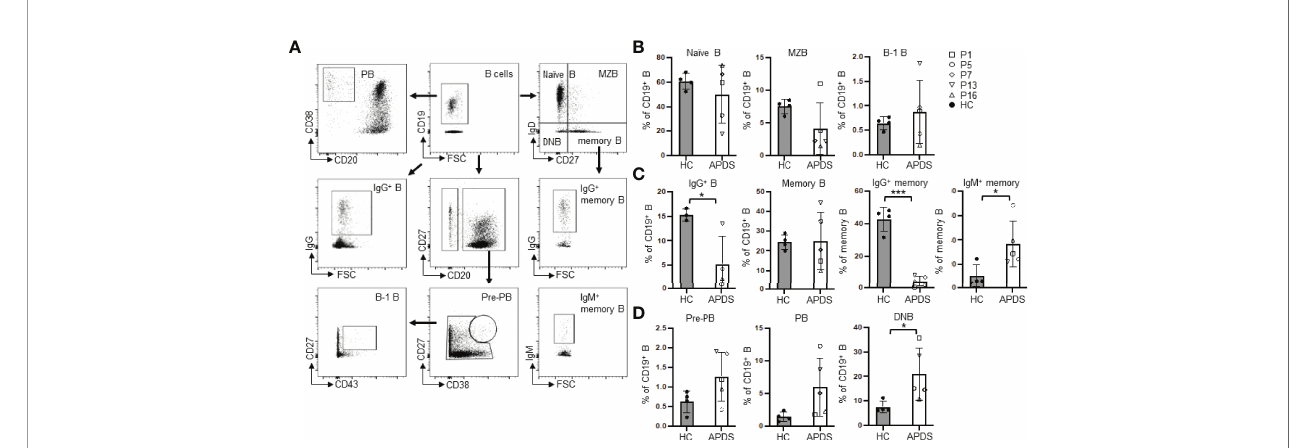
FIGURE 1 | B cell subset distribution in the peripheral blood of APDS patients. (A) Gating strategy for the analysis of different B cell subsets. (B) Percentages of naïve B (CD19 + IgD + CD27 - ), MZB (CD19 + IgD + CD27 + ) and B-1 B (CD20 + CD27 + CD43 + ) cells in healthy controls (HC) and the patients (APDS). (C) Proportions of IgG + (class-switched) B, total memory B (CD19 + IgD - CD27 + ), and IgG + and IgM + memory B cells among the total memory B cells in HC and the patients. (D) Proportions of pre-plasmablast (pre-PB, CD38 hi CD27 hi ), plasmablast (PB, CD20 - CD38 hi ) and double negative B (DNB, CD19 + IgD - CD27 - ) cells in HC and the patients. Grey column, HC (n=4); Open column, patient (n=5). * p < 0.05; *** p < 0.001 (unpaired t-test). Bars indicate mean ± SD.